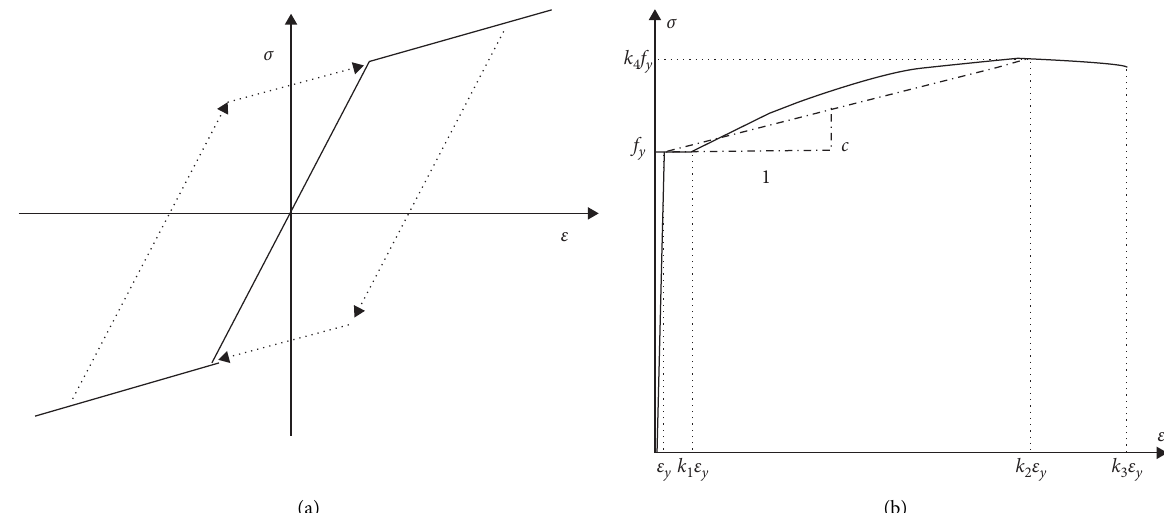
Figure 4: Constitutive model of steel bar. (a) Bilinear kinematic hardening constitutive model. (b) Response of bars under uniaxial tensile load